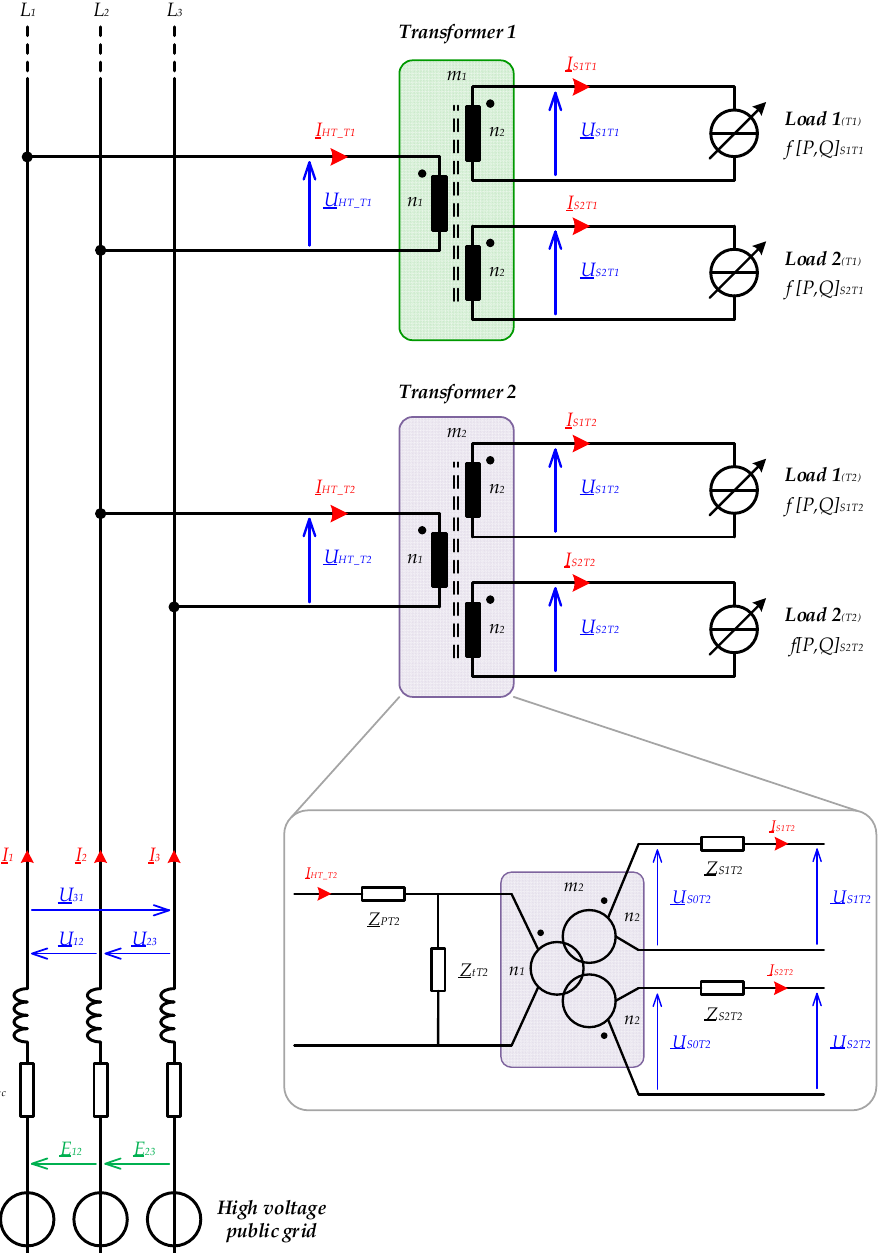
Figure 3. Diagram of the electrical circuit considered for the calculation of the VUF in the case of substations with V-connection schemes.